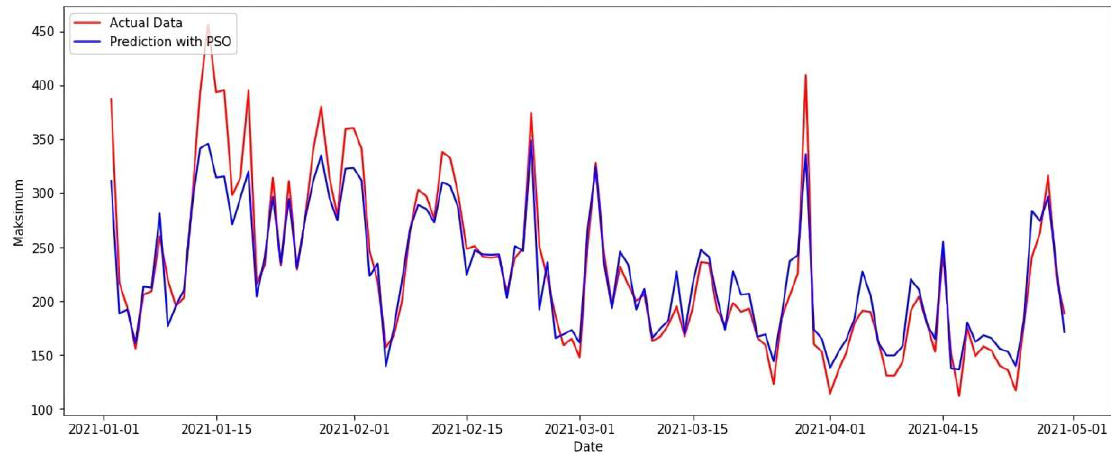
Figure 6. Comparison graph of actual data with